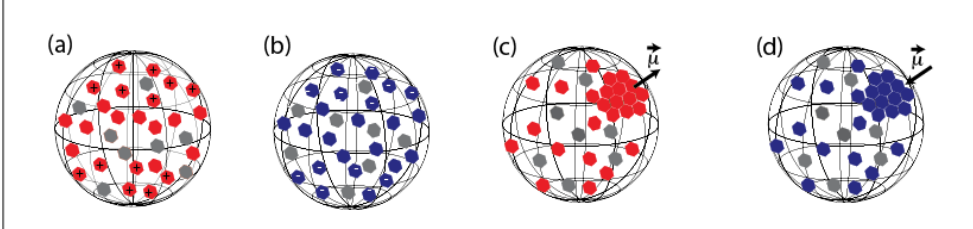
Figure 7. ( a ) Positive and ( b ) negative surface-charged models of droplets for which NPs are ho- mogeneously distributed around the droplet, unlike in dipolar droplet models ( c , d ); grey color is used for NPs with either a positive surface charge (upwards orientation) or with a negative charge (downwards orientation). For each model, the majority of NPs are oriented either upwards or down- wards, in a such way that a global surface charge is obtained: ( a ) → (+) , ( b ) → ( − ) , ( c ) → (+) and ( d ) → ( − )